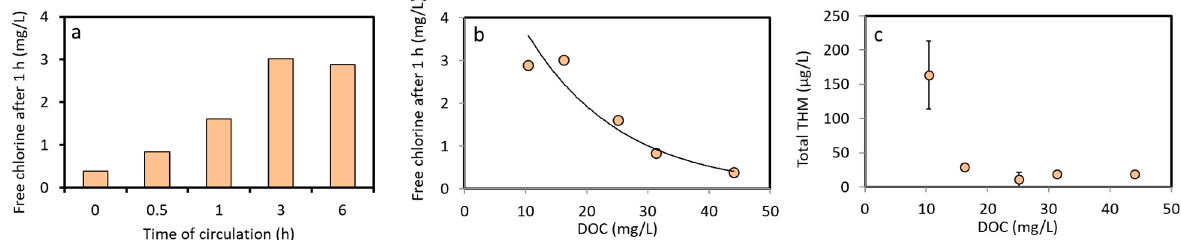
Figure 5. Residual free chlorine after 1 h of incubation ( a ) and as a function of DOC ( b ), and total THM formed ( c ) after 1 h of incubation as a function of DOC. Results for S5 water following differing circulation times.